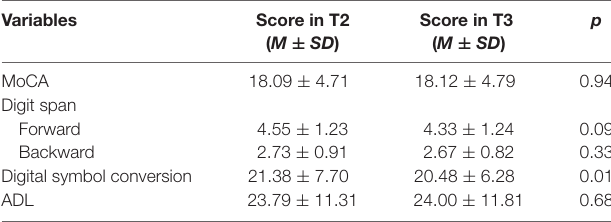
TABLE 2C | Training effect in T2 and T3 (paired sample t -tests, cognitive training group).